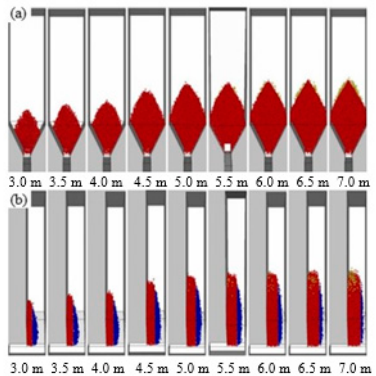
Figure 10. Schematic of the drawn-out ore body: ( a ) front view contrast of the drawn-out ore body; ( b ) side view contrast of the drawn-out ore body. Table 6. Results of recovery indexes in the optimization simulation of caving step. Analog Recovery Difference between Caving Step/m Dilution Ratio/% Number Ratio/% Recovery and Dilution Ratios/% B 1